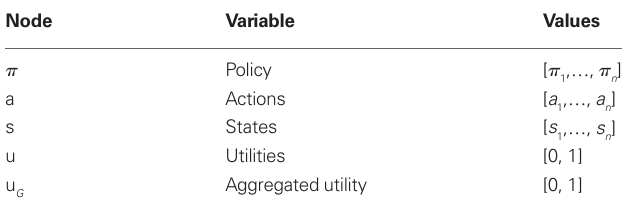
Figure 1 | The Bayesian model of goal-directed decision-making proposed by Botvinick and An (2008); Solway and Botvinick (submitted), which we use as our “baseline model.” See main text for explanation. Table 1 | List of variables used in Figure 1.